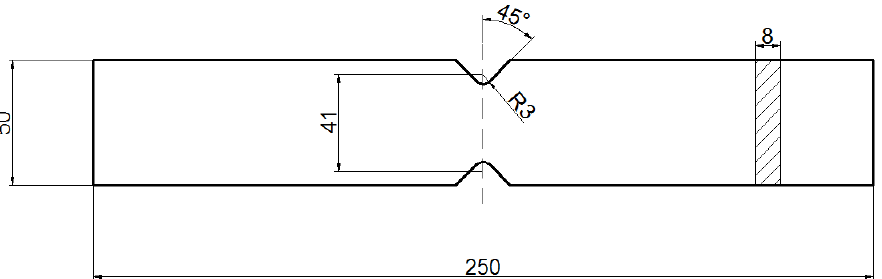
Figure 4. Geometry and dimension of notched fatigue specimen.